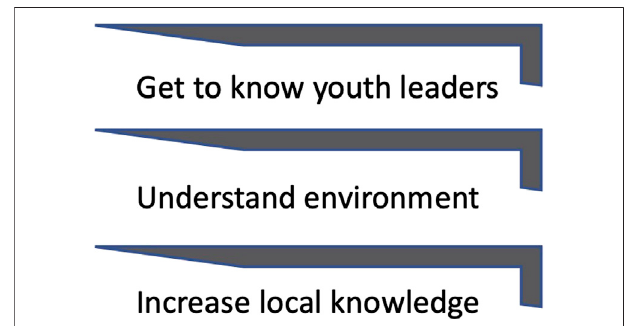
FIGURE 2 | Hierarchy model of researcher prioritizing usual